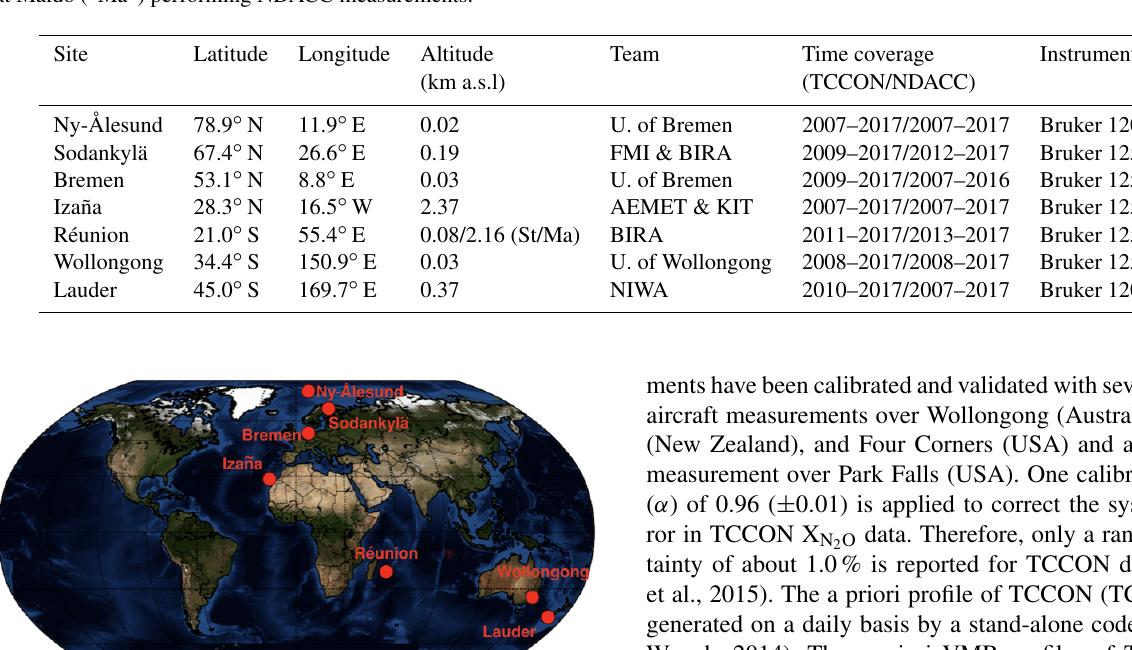
Table 1. Characteristics of the FTIR sites contributing to the present work: location, altitude (kma.s.l.), research team and time coverage of data. Note that there are two observatories at Réunion, one is at Saint-Denis (“St”) performing TCCON measurements and the other one is at Maïdo (“Ma”) performing NDACC measurements.